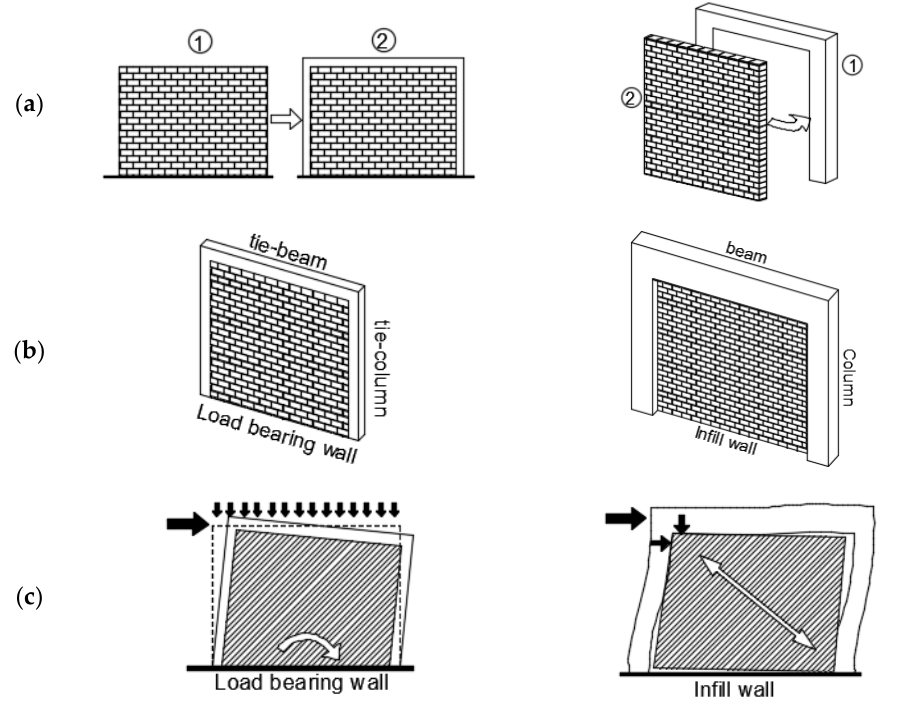
Figure 2. A comparison of confined masonry construction and RC frames with masonry infills. ( a ) Construction sequence, ( b ) Size of concrete elements, ( c ) Seismic response.